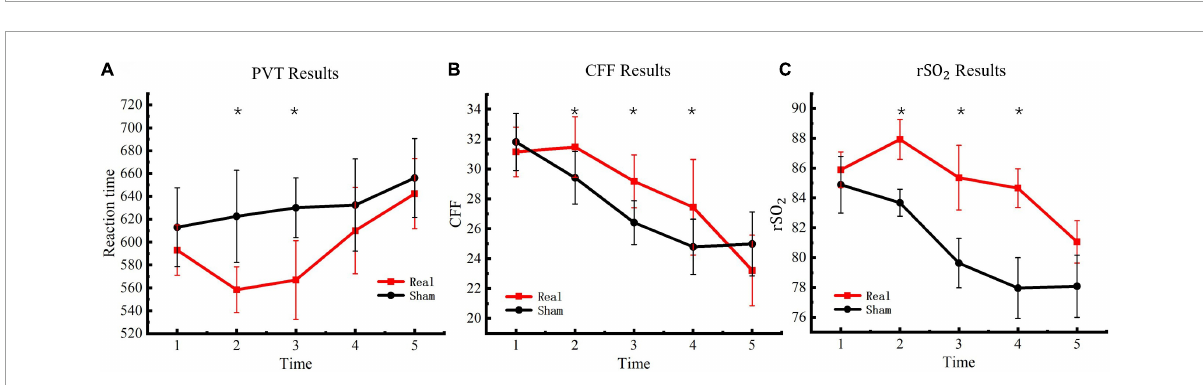
FIGURE4 Critical flicker frequency and regional oxygen saturation results. (A) PVT results. (B) CFF results. (C) rSO 2 results. Asterisks indicate significant differences between real and sham tDCS